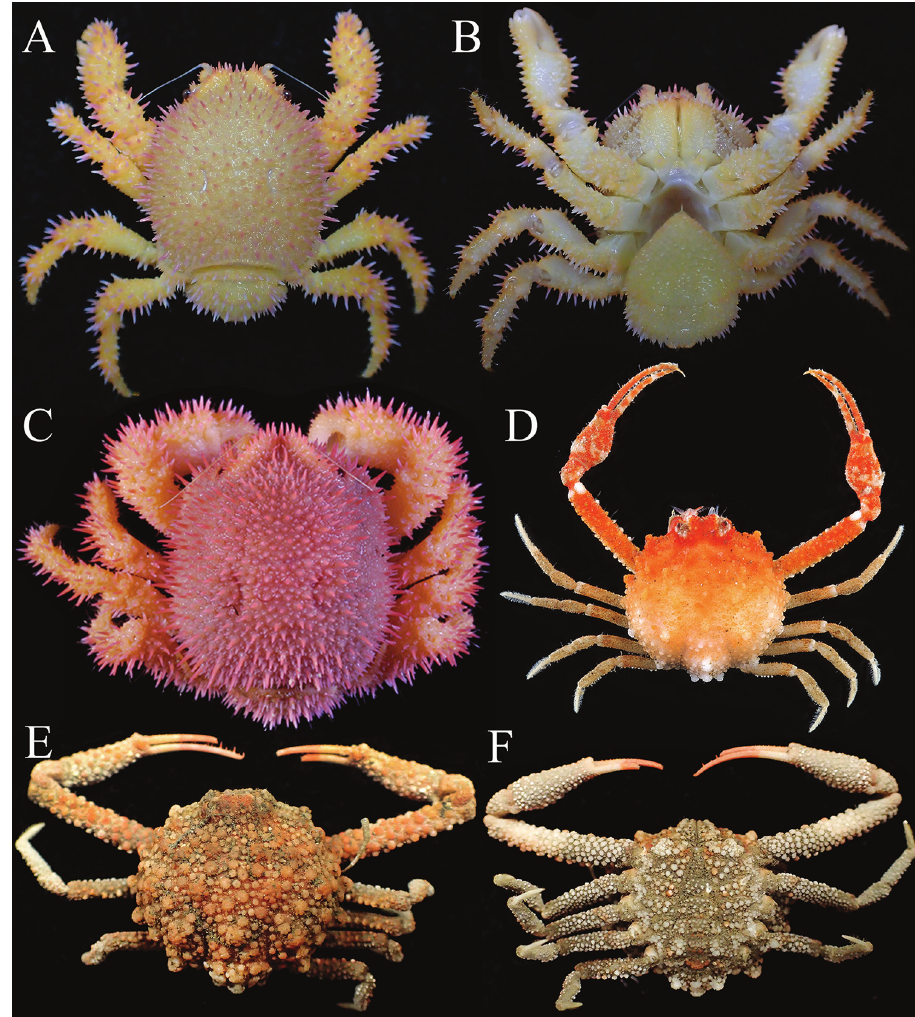
Figure 1. Colour in life. A, B Acanthodromia margarita (Alcock, 1899), female (17.8 × 18.3 mm) (ASIZ 75484), Taiwan C Acanthodromia margarita (Alcock, 1899), female (17.7 × 19.2 mm) (ZRC 2008.1420), Philippines D Pariphiculus agariciferus , Ihle, 1918, male (11.9 × 12.1 mm) (ZRC 2009.471), Vanuatu E, F Pariphiculus stellatus sp. n., holotype male (27.7 × 24.5 mm) (ASIZ 75485), Taiwan. A, C, D, E overall dorsal view; B, F ventral